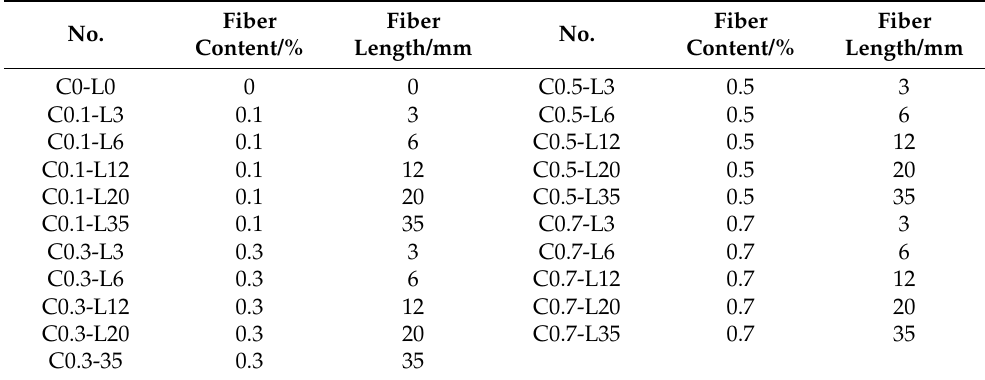
Table 5. Mixture designs of the test specimens.